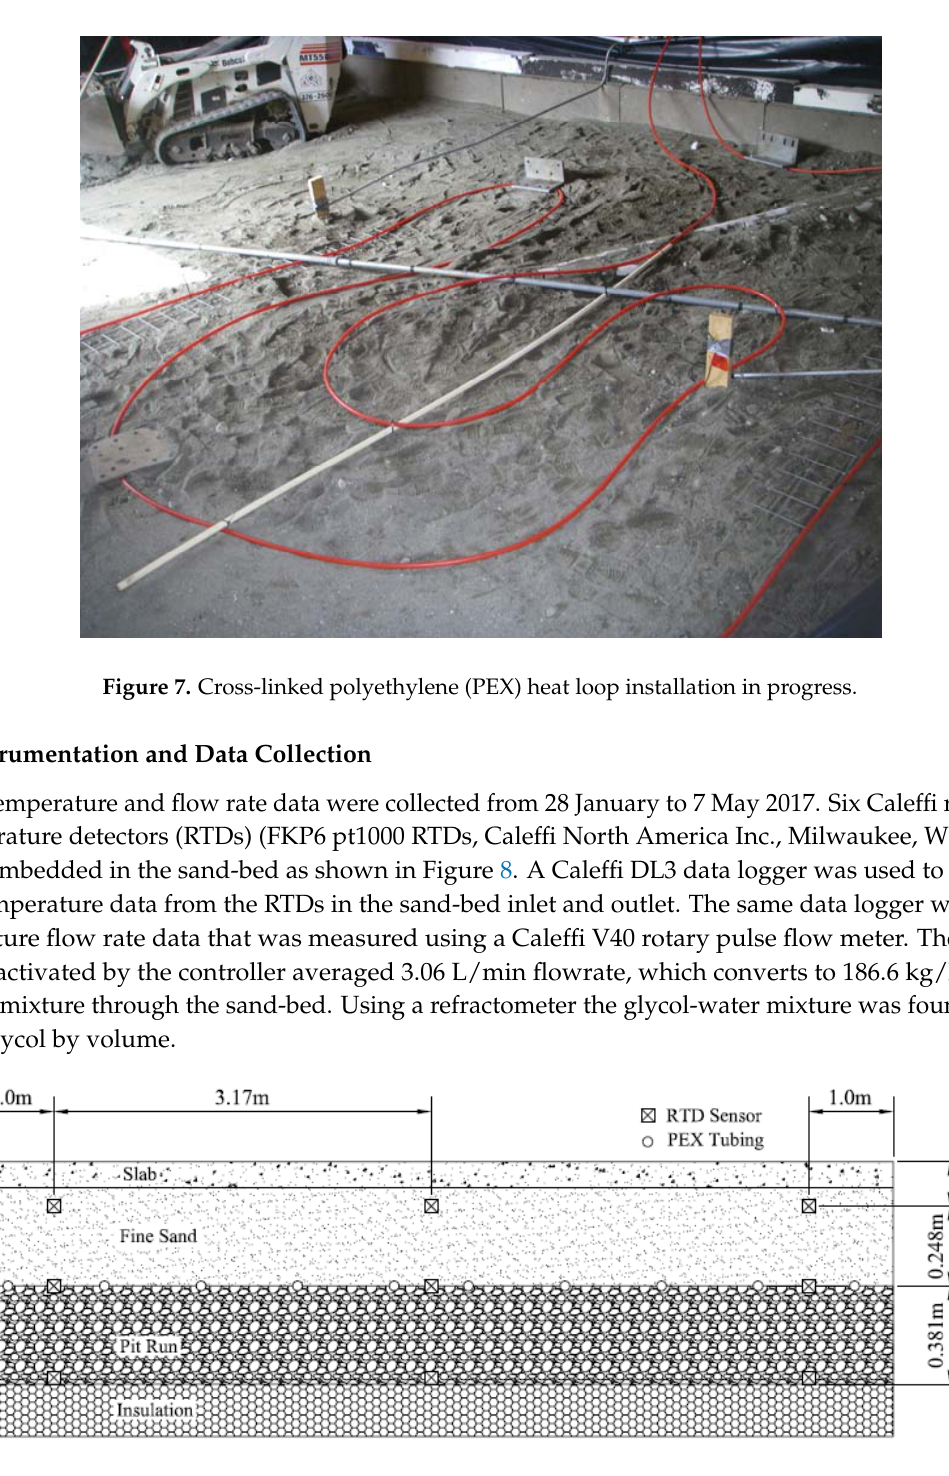
Figure 8. Resistive temperature detectors (RTD) locations in sand ‐ bed.